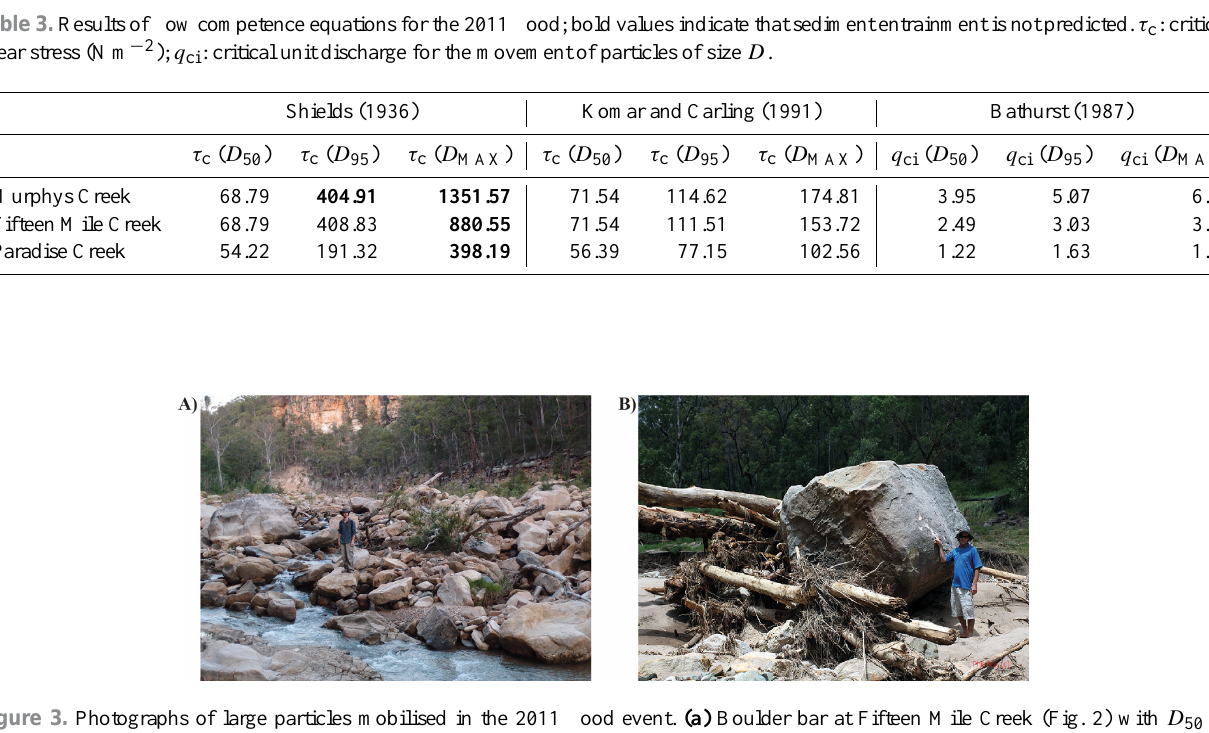
Figure 3. Photographs of large particles mobilised in the 2011 flood event. (a) Boulder bar at Fifteen Mile Creek (Fig. 2) with D 50 of 2325mm. (b) Large boulder with b axis of 4820mm at Paradise Creek (Fig. 2).